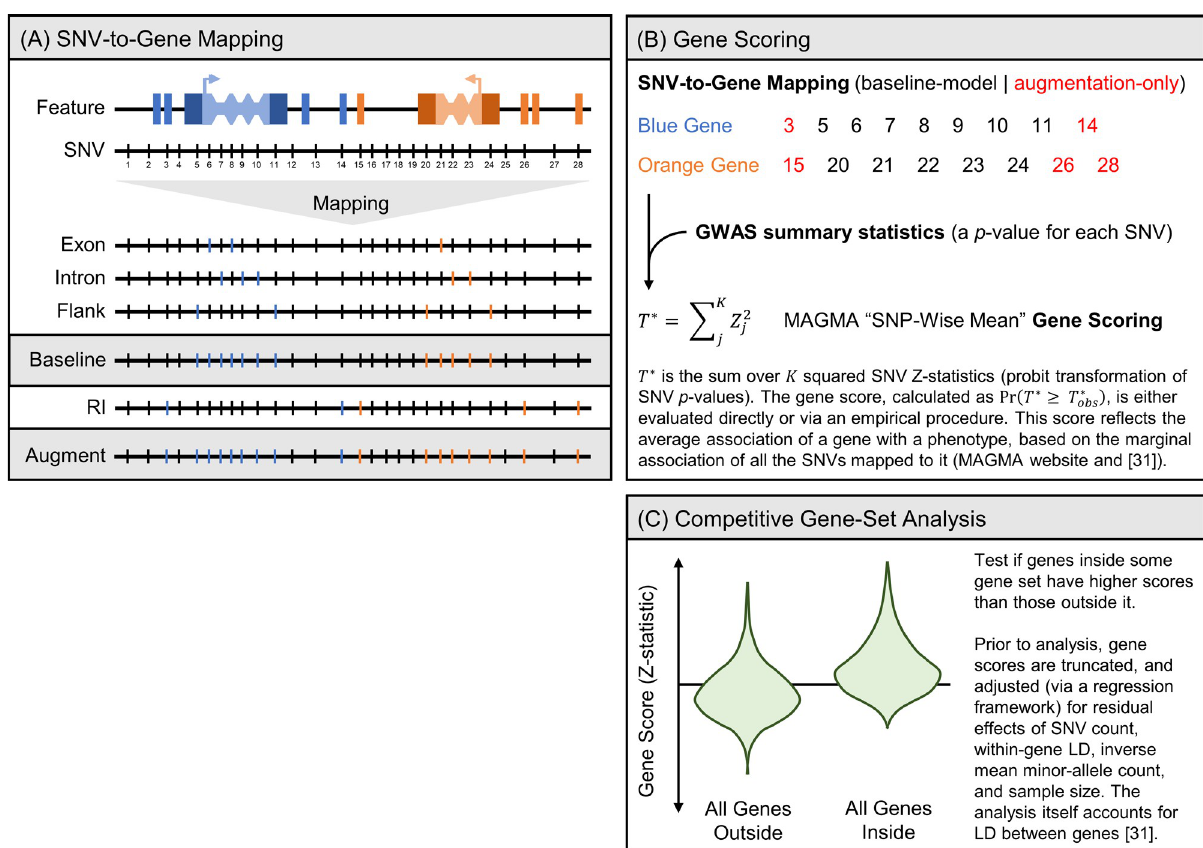
Fig 1. An overview of gene-set analyses for GWAS data. Gene-set analyses for GWAS data require that SNVs are mapped to genes (A) SNV-to-Gene Mapping, so that GWAS results (that is, SNV-level associations for all tested SNVs) can be used to test genes for association with a phenotype (B) Gene Scoring. The resulting gene scores are then used to identify biological processes enriched for phenotype association (C) Competitive Gene-Set Analysis. Everything is illustrated in the context of our work, which leveraged MAGMA, one of the most popular tools for gene-set analysis for GWAS data. Abbreviations: RI (regulatory